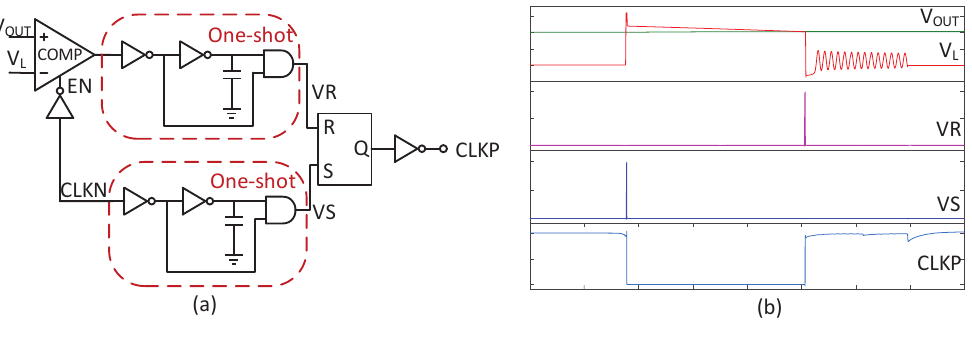
Figure 10. ( a ) The ZCD; ( b ) Simulated waveform of